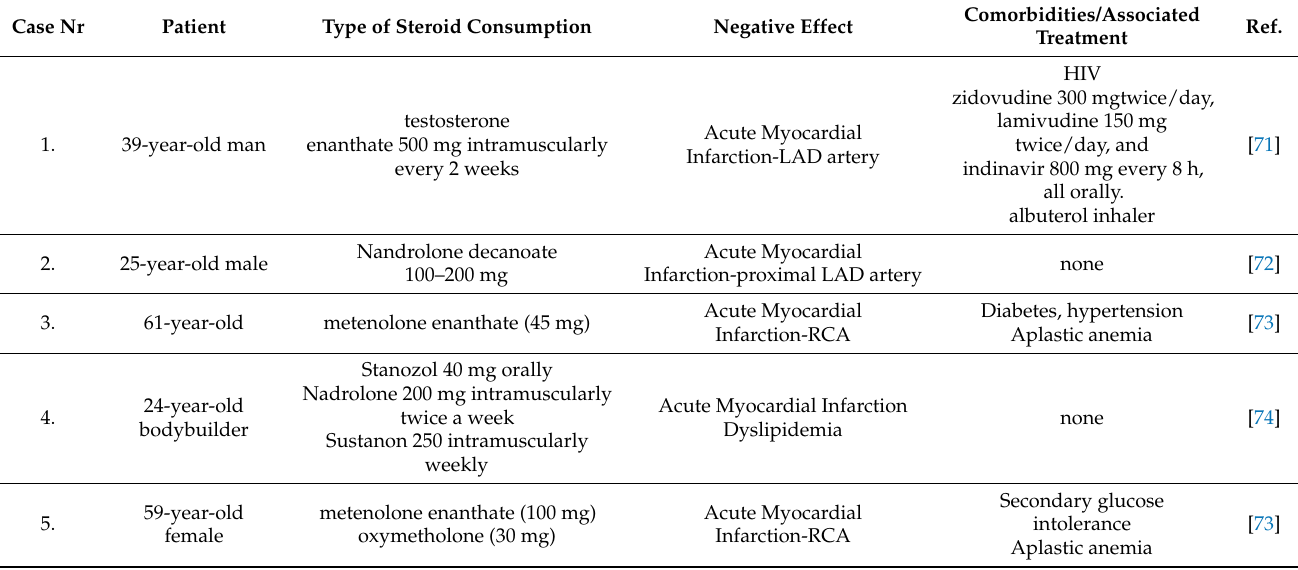
Table 4. Examples of acute myocardial infarction after AAS